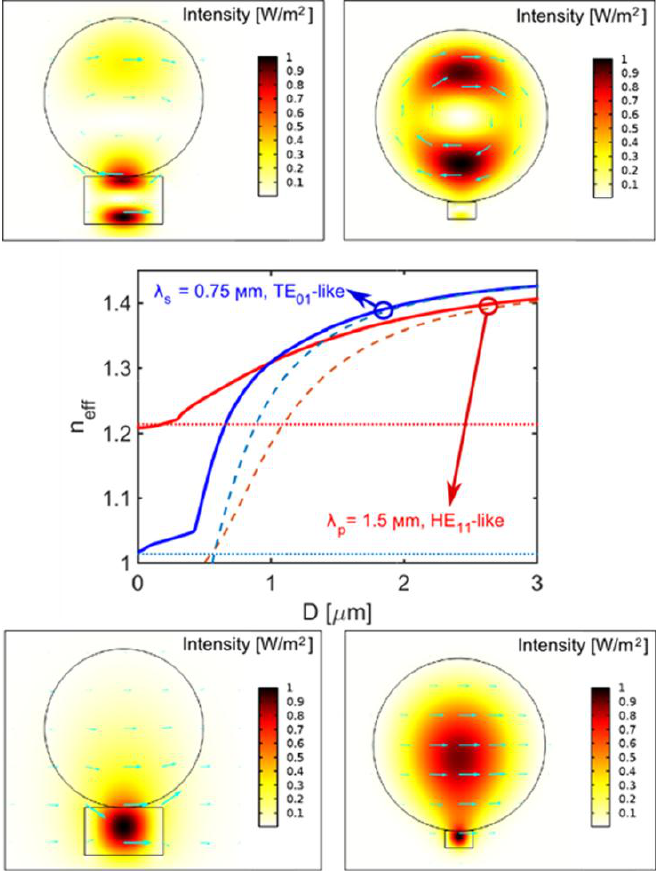
Figure 2. HE 11 -like mode at  p = 1.5  m and TE 01 -like mode at  s = 0.75  m: light intensity and the electric field polarization. Modal profiles are plotted for D = 3  m (right panels) and D ≈ 1  m (corresponding to phase matching, left panels). The effective indices as functions of the fiber diameter are shown in the central panel. The waveguide dimensions are: H = 300 nm, W = 495 nm. The effective indices of pure MF modes and pure LNOI waveguide modes are plotted with dashed lines and dotted lines,